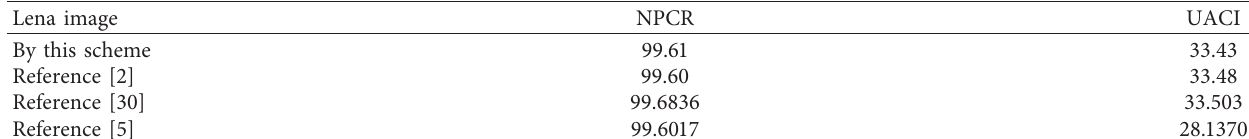
Table 4: Comparison of NPCR and UACI with the image “lena.”